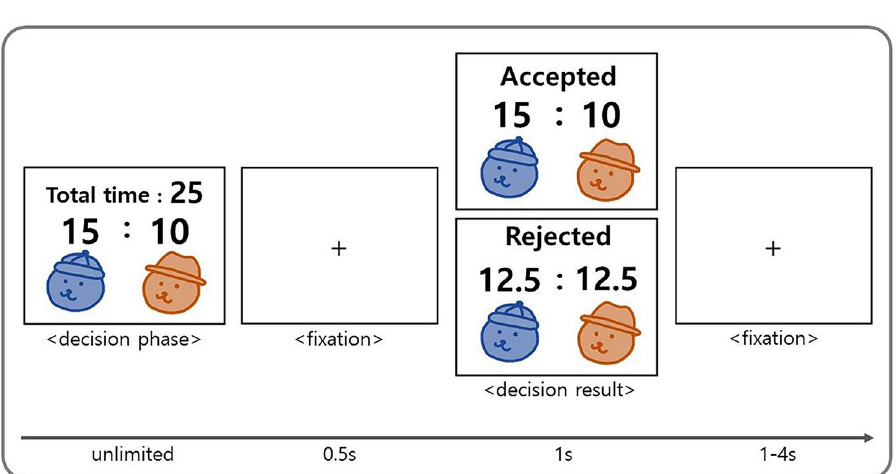
Figure 2. Schematic diagram of the BIDG. In the decision phase, a suggested allocation was displayed and participants were asked to choose to either accept or reject the suggestion. If they accepted, the time resource was distributed as suggested, whereas it was evenly distributed if rejected, and the decision result was displayed for 1 s following a fixation period of 0.5 s after the